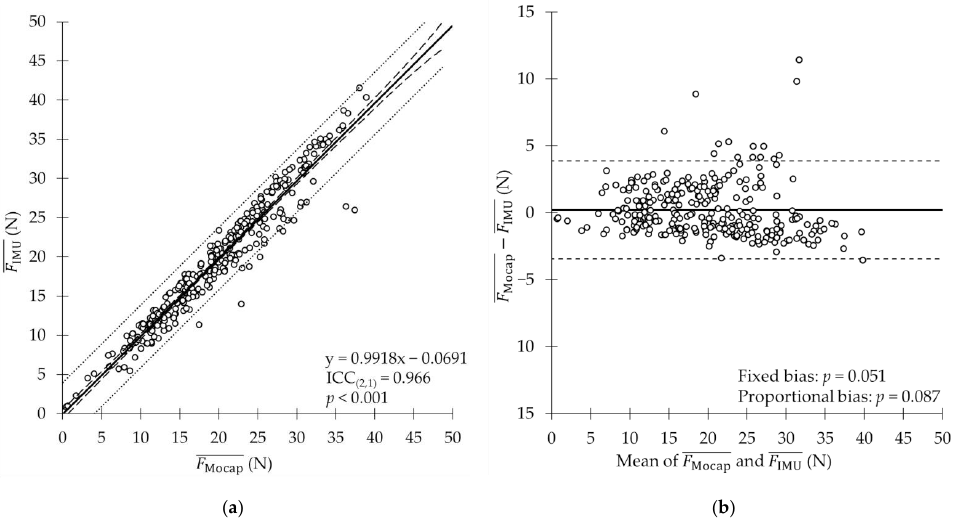
Figure 8. ( a ) Comparison of 𝐹 Mocap ̅̅̅̅̅̅̅̅̅ and 𝐹 IMU ̅̅̅̅̅̅ . Solid line represents regression line, dashed line represents confidence interval of regression line, and dotted line represents prediction interval. ( b ) Results of Bland – Altman analysis of mean propulsive force. Dashed line represents upper and lower limits of confidence interval for 95% LOA.